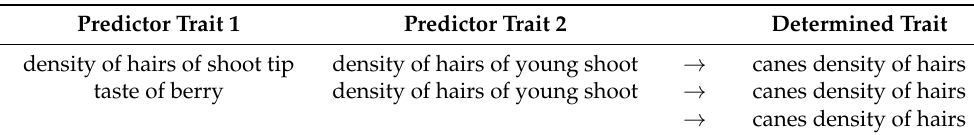
Table 6. Two examples when two traits determine another trait perfectly.